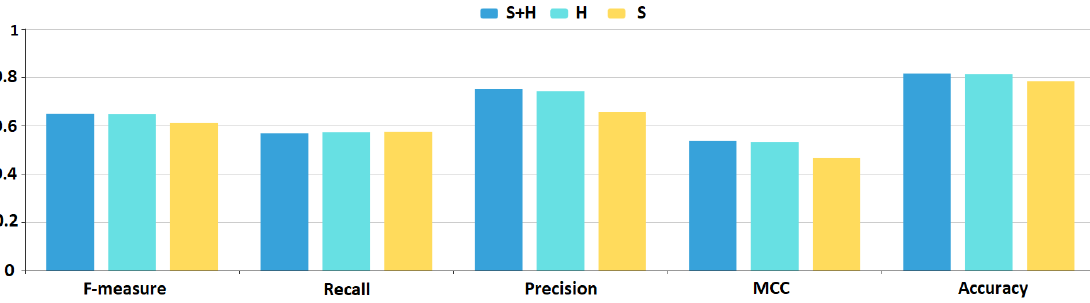
Figure 11. Random forest.